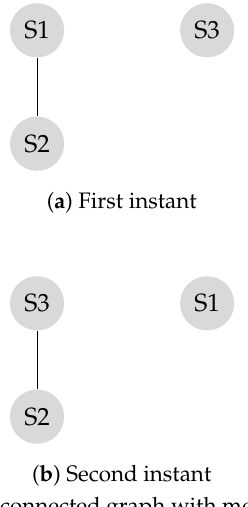
Figure 7. Disconnected graph with mobile